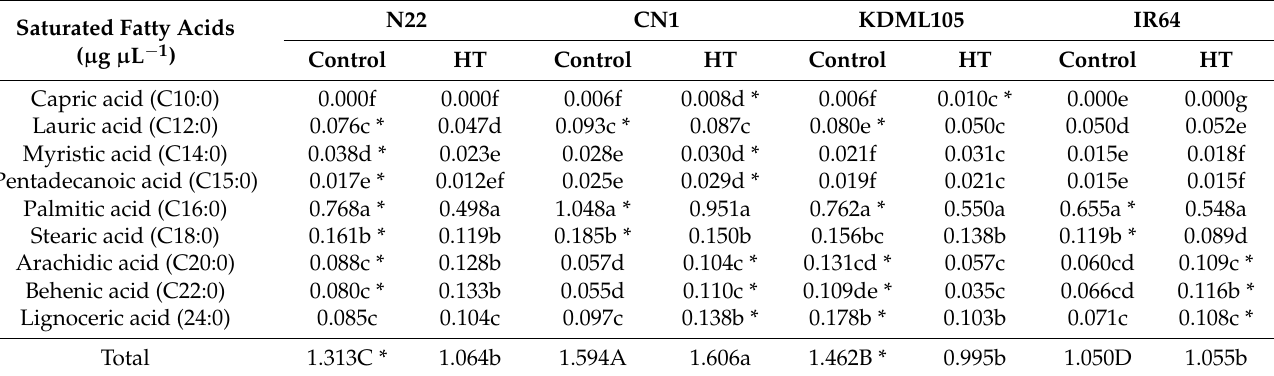
Table 1. Saturated fatty acids in the control and HT-stressed leaves of four rice